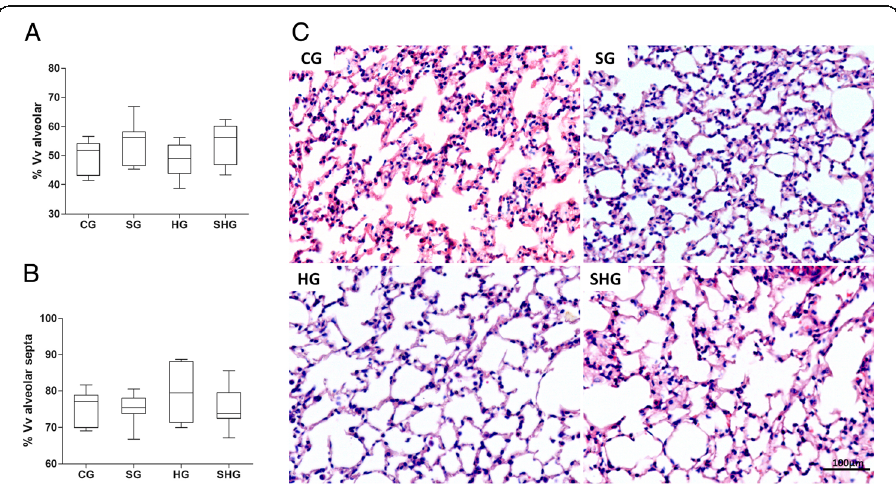
Fig. 1 Stereological analyses of lung sections. a Volume density of alveolar septa and b volume density of alveolar airspace. c Histological section of lung parenchyma stained with HE. Barr=50 μ m. CG control